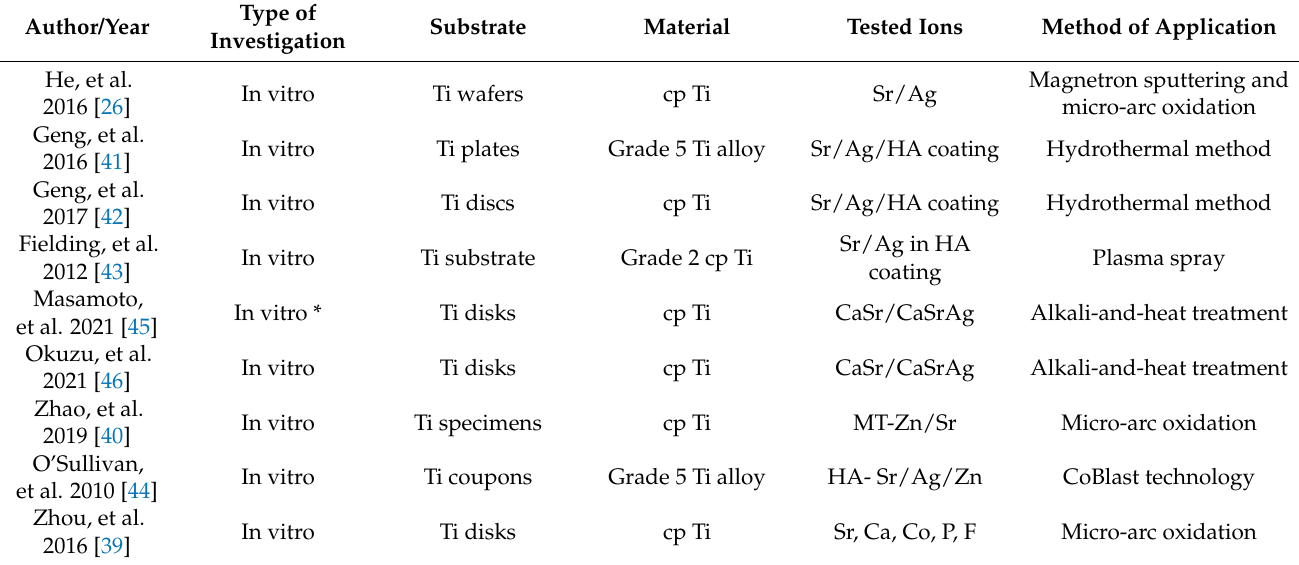
Table 1. General characteristics of included